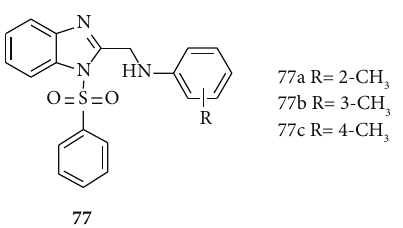
Figure 7: Chemical structures of anti-inflammatory active benzimidazole-sulfonyl derivatives.